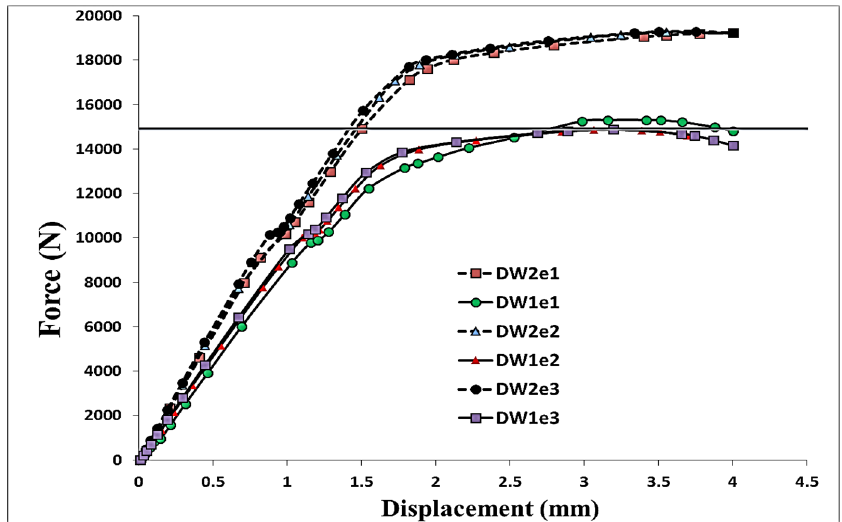
Figure 5. Numerical load-displacement curves of double bolt joints with different